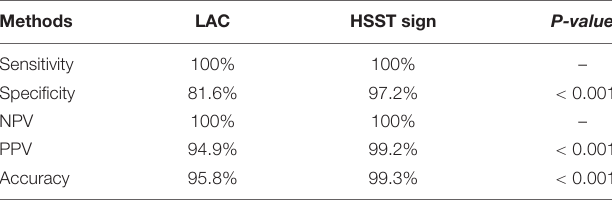
TABLE 2 | Test evaluation between two